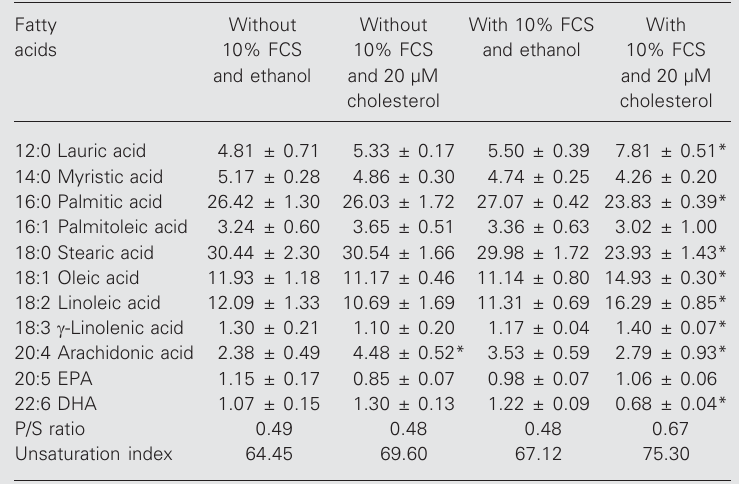
Table 1. Effect of cholesterol on the fatty acid composition of rat fetal enterocytes after 24 h in